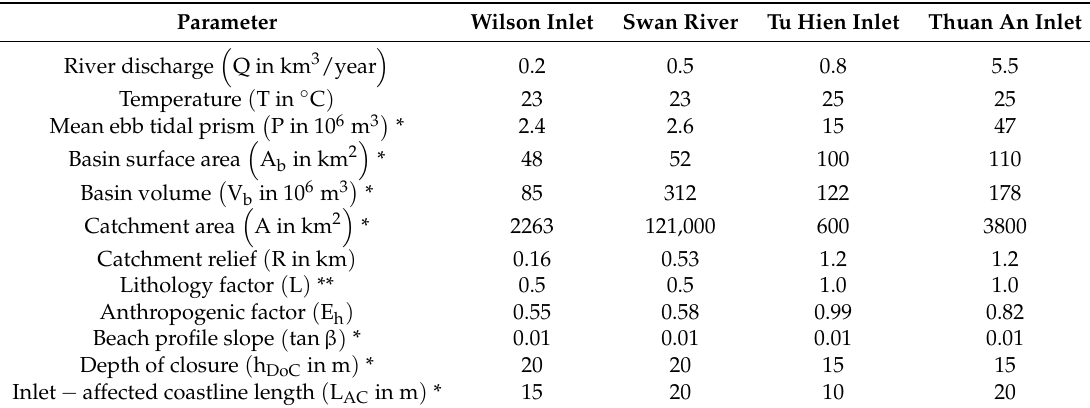
Table 1. Model input parameters (present conditions).